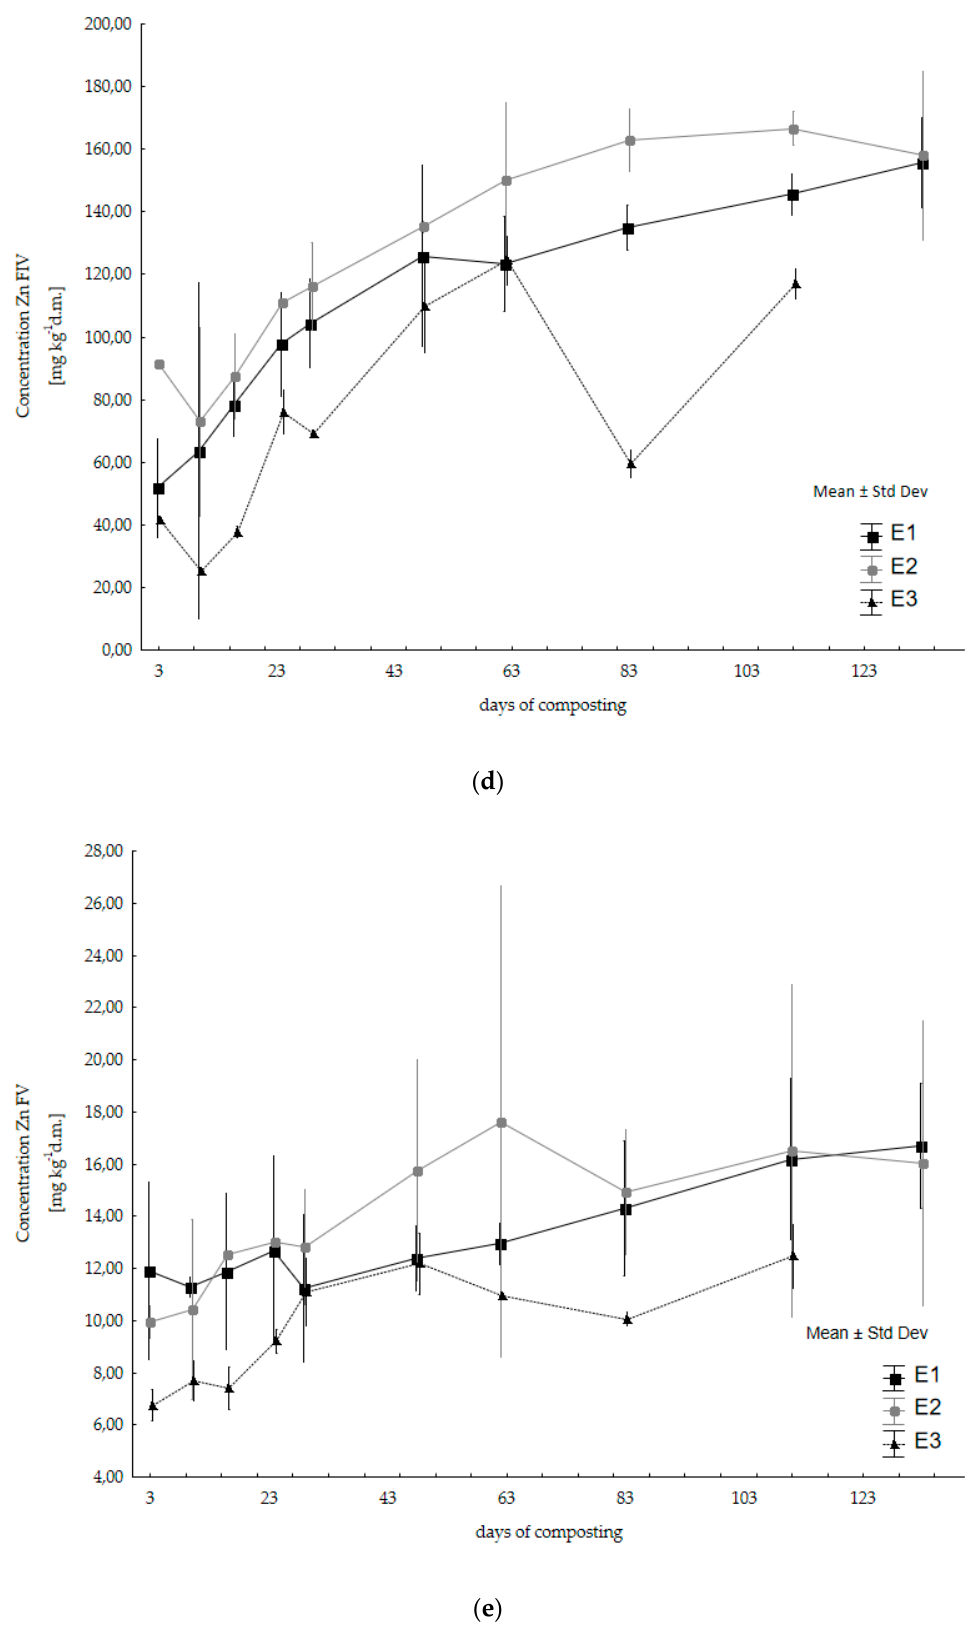
Figure 3. Concentration of Zn in particular fractions FI ( a ), FII ( b ), FIII ( c ), FIV ( d ), and FV ( e ) in stages E1, E2, E3.